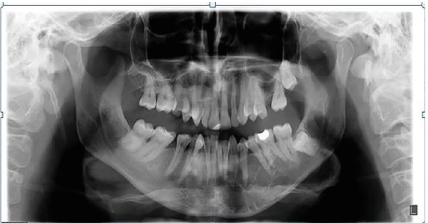
Figure 1: First OPG with multicystical lesion in the left mandible surrounding teeth 33 to 36